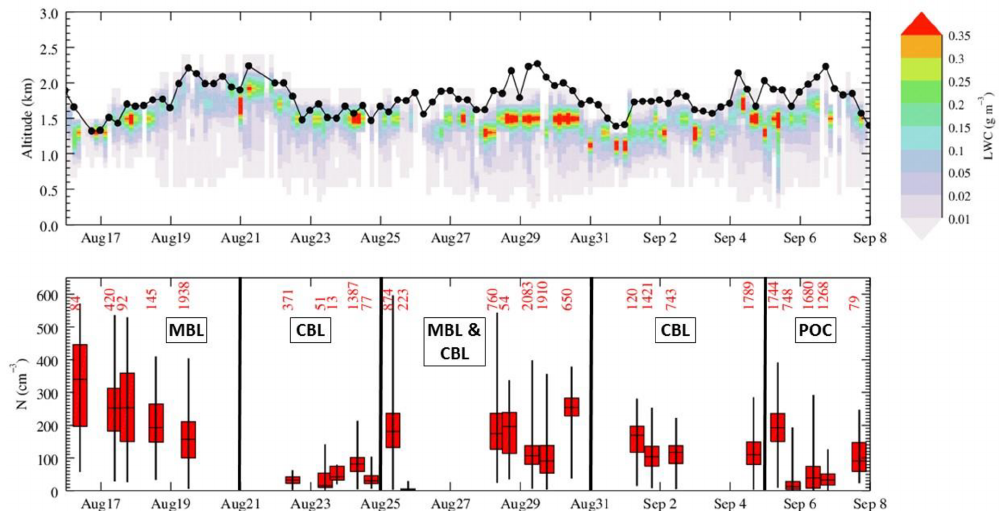
Figure 13. (i) Vertical profiles of cloud LWC from the Met Office CLUMP model (colour scale) and the position of the MBL inversion derived from radiosonde ascents (black circles) and (ii) box-and-whisker plots showing the cloud drop number concentration measured from the CDP on each flight. The median value is shown by the horizontal black line, the 25 and 75 percentiles by the limits of the boxes, and the range by the whiskers. CDP data are selected for points where LWC > 0.05gm − 3 and N > 5cm − 3 . The number of 1Hz data points that meet these thresholds is displayed on the figure for each flight. The general discrimination between regimes shown in Fig. 9 is shown by the bold vertical